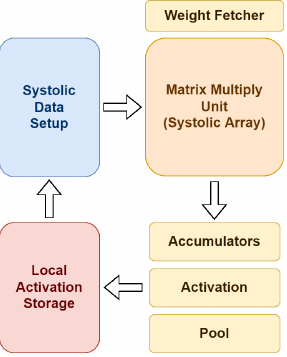
Figure 5. Google Tensor processing unit architecture.